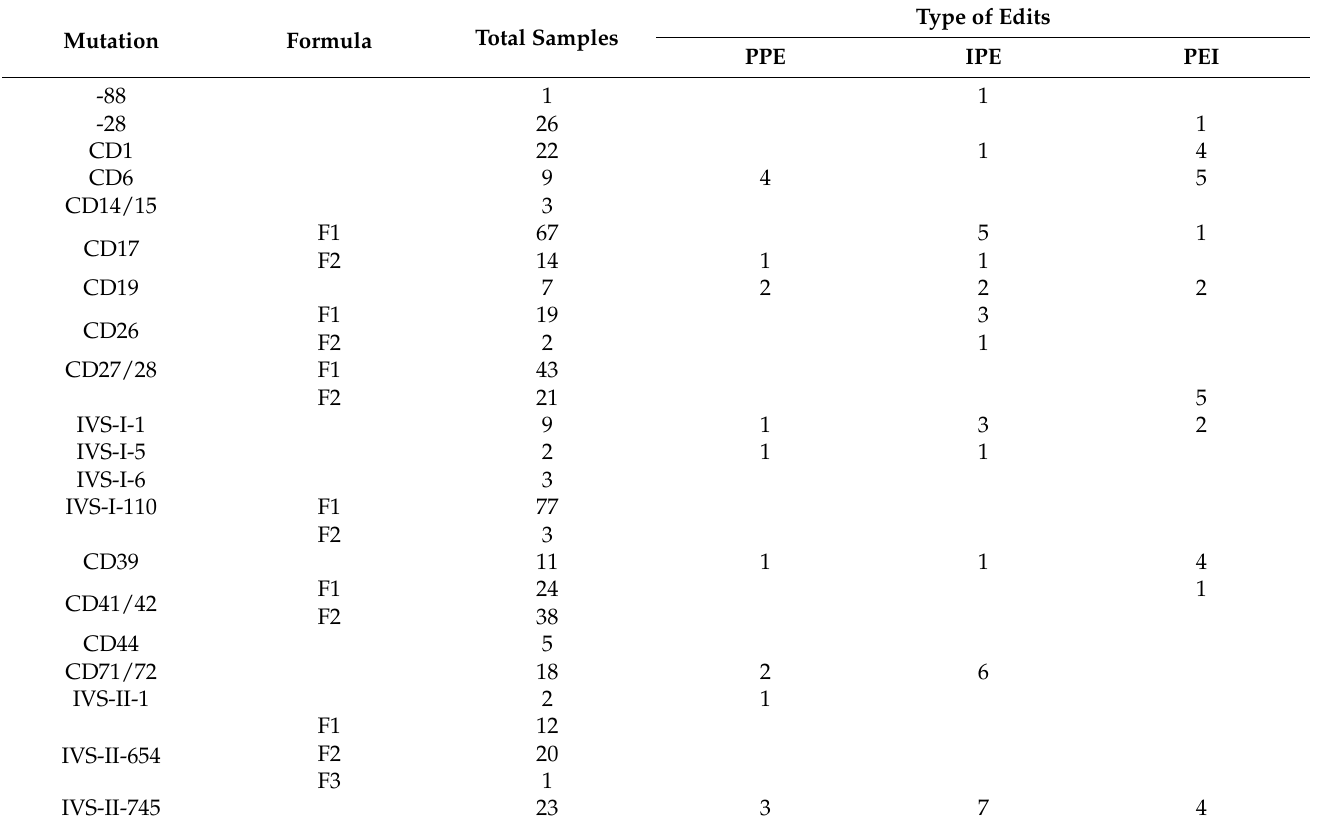
Table 2. The edits at each beta-thal mutation site, including sampling numbers and the edit number of PPE, IPE, and